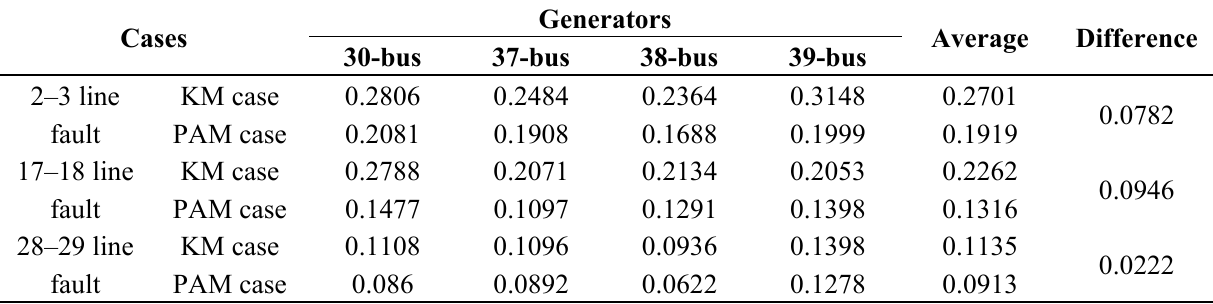
Table 4. Comparison of the Dissimilarity Index (DI) between original and each reduced